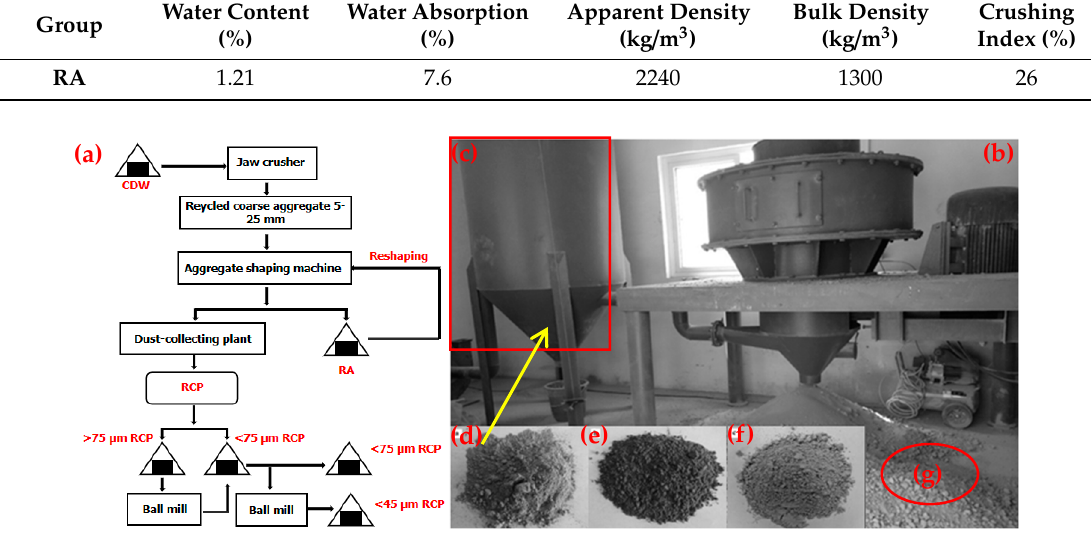
Figure 1. ( a ) Preparation process of recycled concrete powder (RCP), ( b ) reshaping machine, ( c ) dust-collecting device, ( d ) RCP, ( e ) recycled brick powder (RBP), ( f ) recycled mortar powder (RMP), and ( g ) reinforced RA.